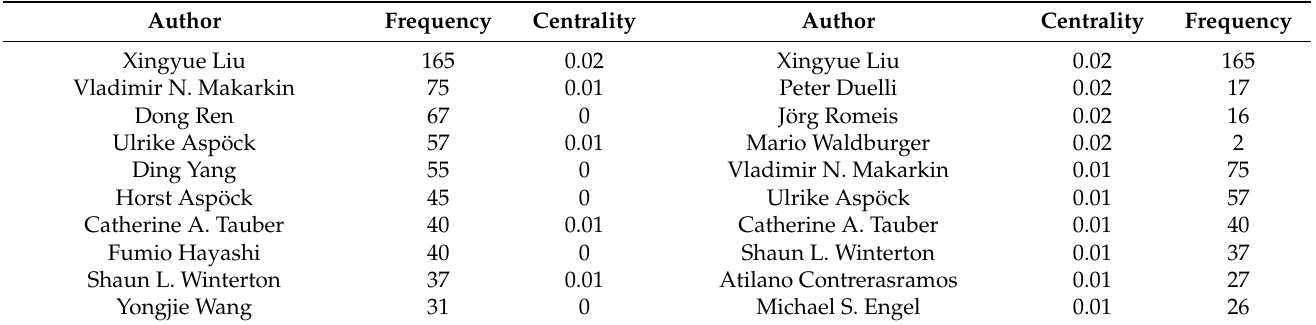
Figure 8. Author collaboration network. The node size represents the author’s publication frequency, and the connection line between nodes represents cooperation. Colors of the links, changing from light grey to red, display the corresponding formation year of the links between 1995 and 2021. Table 7. Top 10 authors in terms of frequency and